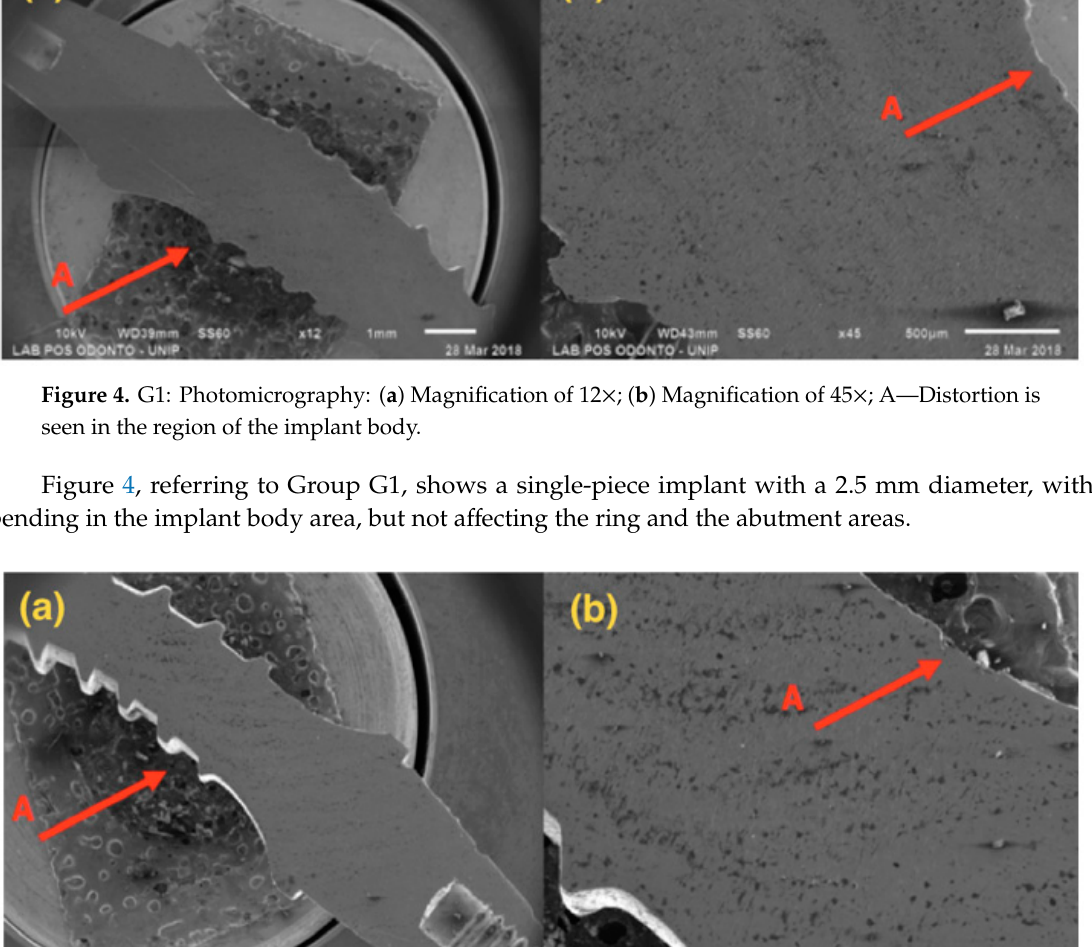
Figure 5. G2: Photomicrography: ( a ) Magnification of 12×; ( b ) Magnification of 45×; A—Distortion is seen in the region of the implant